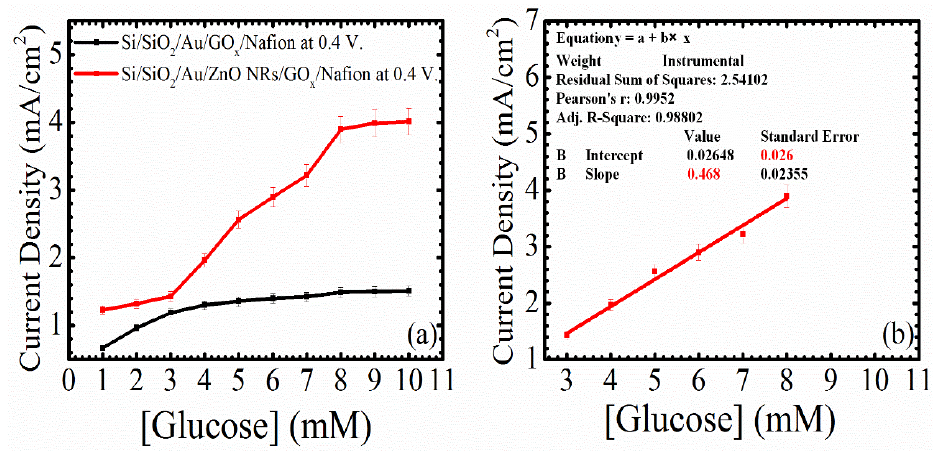
Figure 7. ( a ) Current density of Si/SiO 2 /Au/ZnO NRs/GO x /Nafion (device) and Si/SiO 2 /Au/GO x /Nafion (baseline) as a function of different glucose concentrations at 0.4 V;